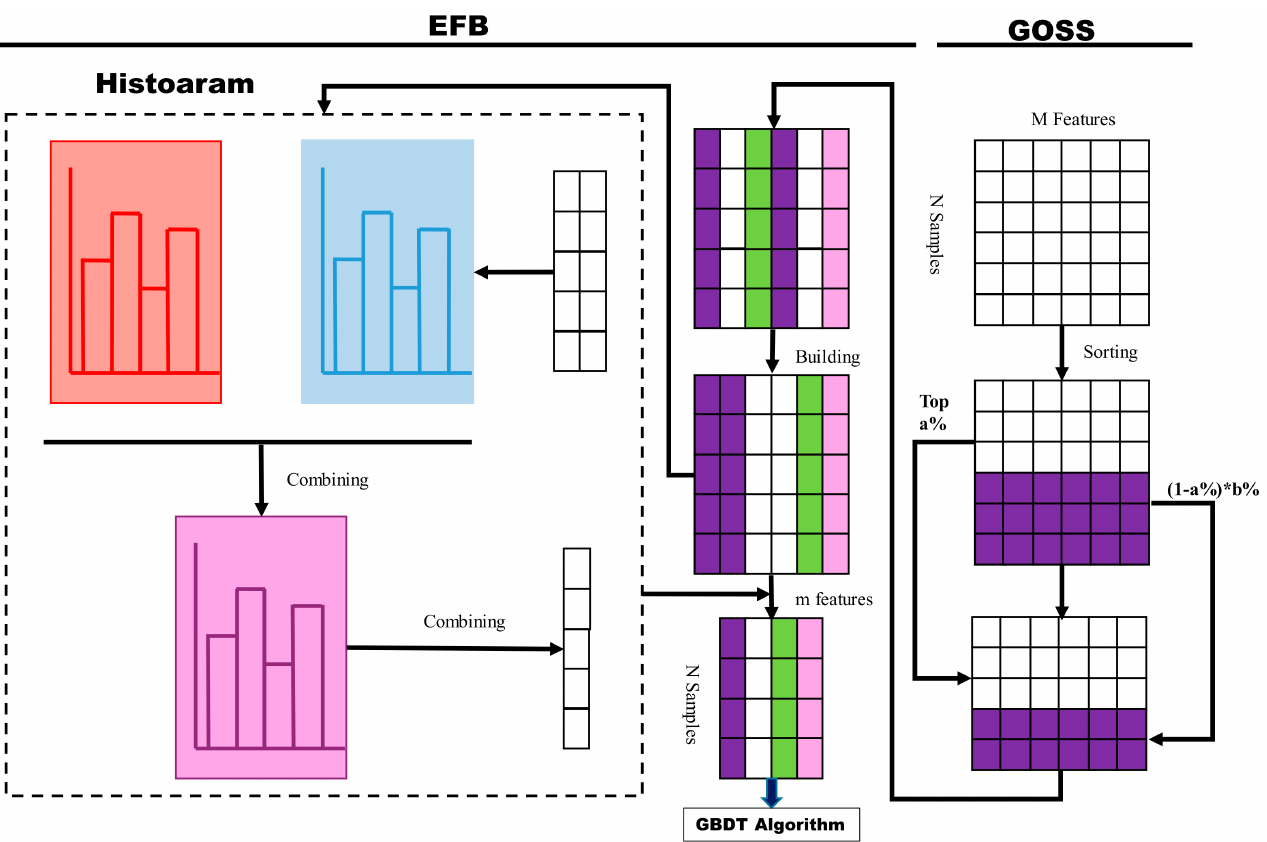
Figure 1. A decision tree algorithm based on Hisgram, adopts